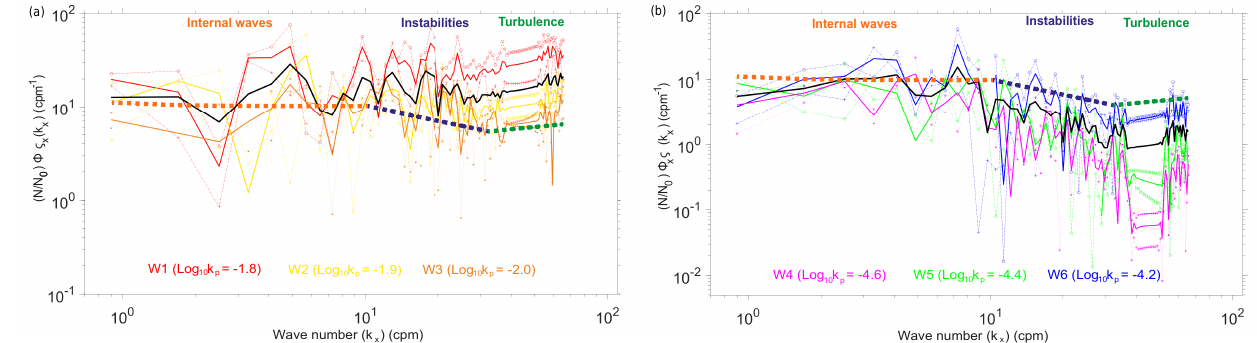
Figure 6. Average horizontal spectrum of the vertical displacements of reflectors inside windows W1–W6 (see location and color code in Fig. 5). (a) Spectra of individual reflectors in “high-diffusivity” areas (thin dotted lines), average within windows W1 (red solid line), W2 (yellow solid line), and W3 (orange solid line), and average of the three “high-diffusivity” windows (thick solid black line). (b) Spectrum of individual reflectors in “low-diffusivity” areas (thin dotted lines), average within windows W4 (magenta solid line), W5 (green solid line), and W6 (blue solid line), and average of the three “low-diffusivity” windows (thick solid black line). The reference lines are the theoretical slopes corresponding to the GM79 model for the internal wave subrange (brown dotted line), Kelvin–Helmholtz instabilities for the transitional subrange (dark blue dotted line), and Batchelor59 model for turbulence (dark green dotted line). Legend: values of diapycnal diffusivity using spectral values at the turbulent subrange within each of the analyzed windows (same color code as for windows